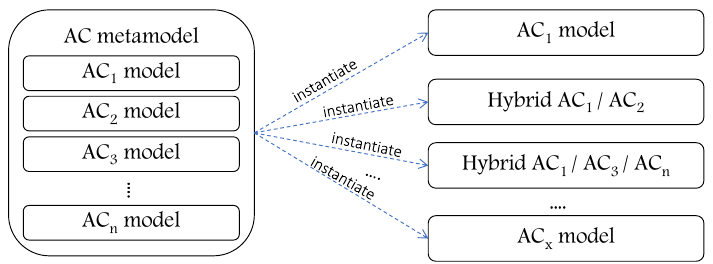
Figure 5. Illustration for AC metamodel